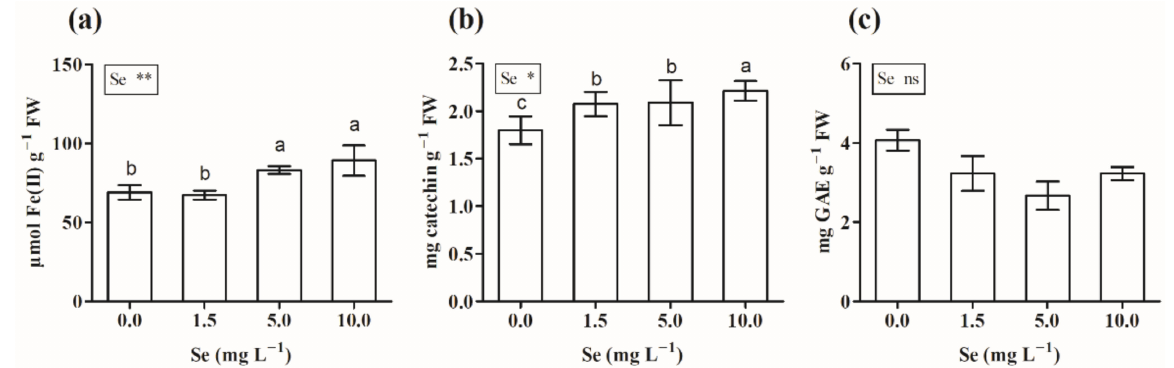
Figure 4. Antioxidant capacity measured by FRAP assay ( a ), flavonoid ( b ), and total phenol ( c ) contents in microgreens of P. oleracea grown indoors under controlled conditions with different concentrations of Se in the substrate. Bars indicated by the same letter are not statistically different for p = 0.05 after Duncan’s test. Significance level: ** p ≤ 0.01; * p ≤ 0.05; ns = not